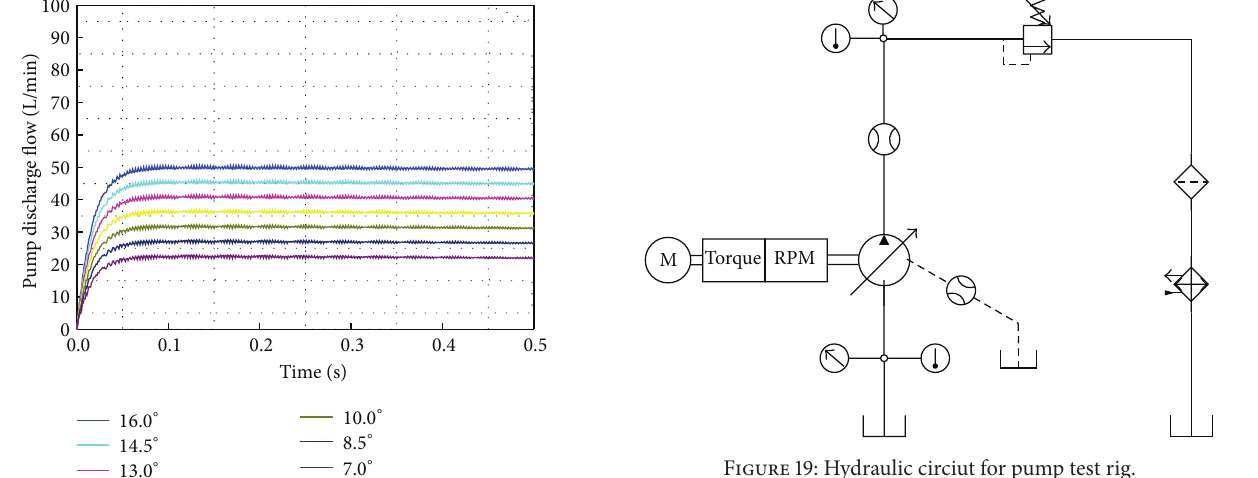
Figure 19: Hydraulic circiut for pump test rig.